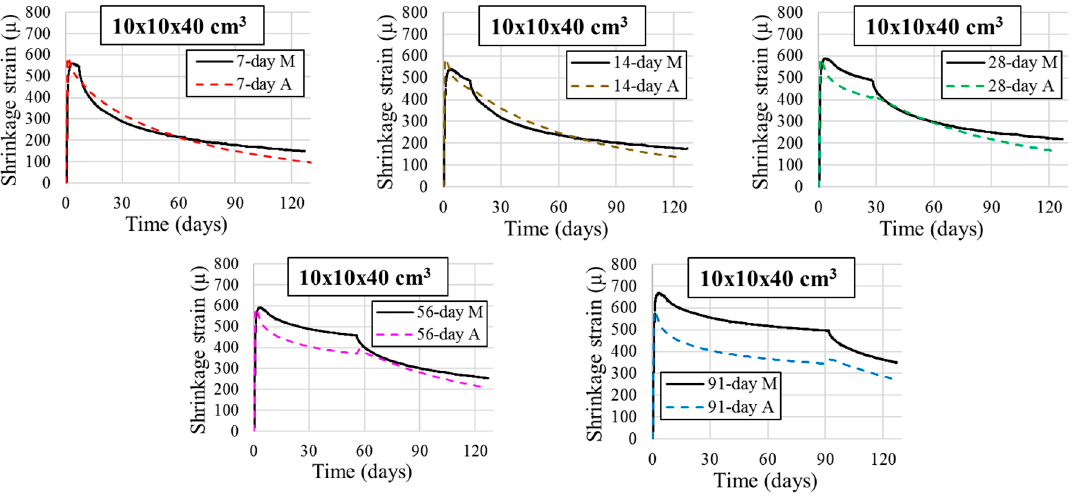
Figure 11. Concrete shrinkage strain in 100 × 100 × 400 mm 3 specimens (M-Measured and A-Analytical).